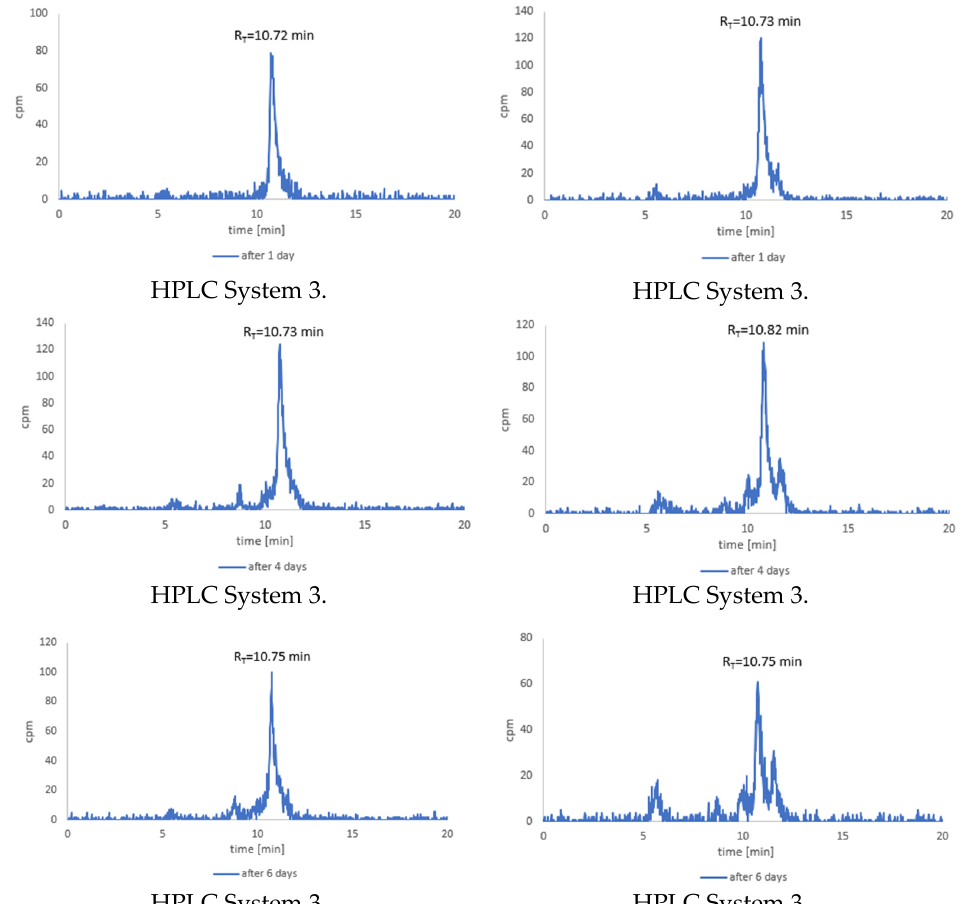
Figure 6. RP-HPLC radiochromatograms (System 3) of the stability studies of the 177 Lu-1 radioconjugate in Cys ( left , after 1 day RCP 98.2 ± 2.5%, n = 3; after 4 days RCP 94.5 ± 3.0, n = 3; after 6 days RCP 93.0 ± 3.6%, n = 3) and His ( right , after 1 day RCP 95.6 ± 2.5%, n = 3; after 4 days RCP 82.2 ± 3.2%, n = 3; after 6 days RCP 64.5 ± 4.1%, n = 3) solutions recorded after different time intervals.